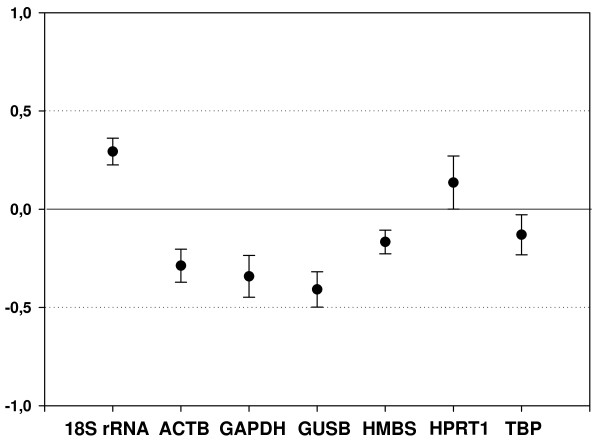
Equivalence test for the seven candidate housekeeping genes in the white matter and GBM sample groups. The differences of means (solid circles) and the matching symmetrical confidence intervals (whiskers) are shown for the logarithmized relative expression of each reference gene. Y-axis represents the fold changes in expression levels between tumor and normal tissues. The deviation area from -1 to 1 indicates fold changes ≤ 2. If the symmetrical confidence interval is included in the deviation area and contains zero, the gene is considered equivalently expressed.